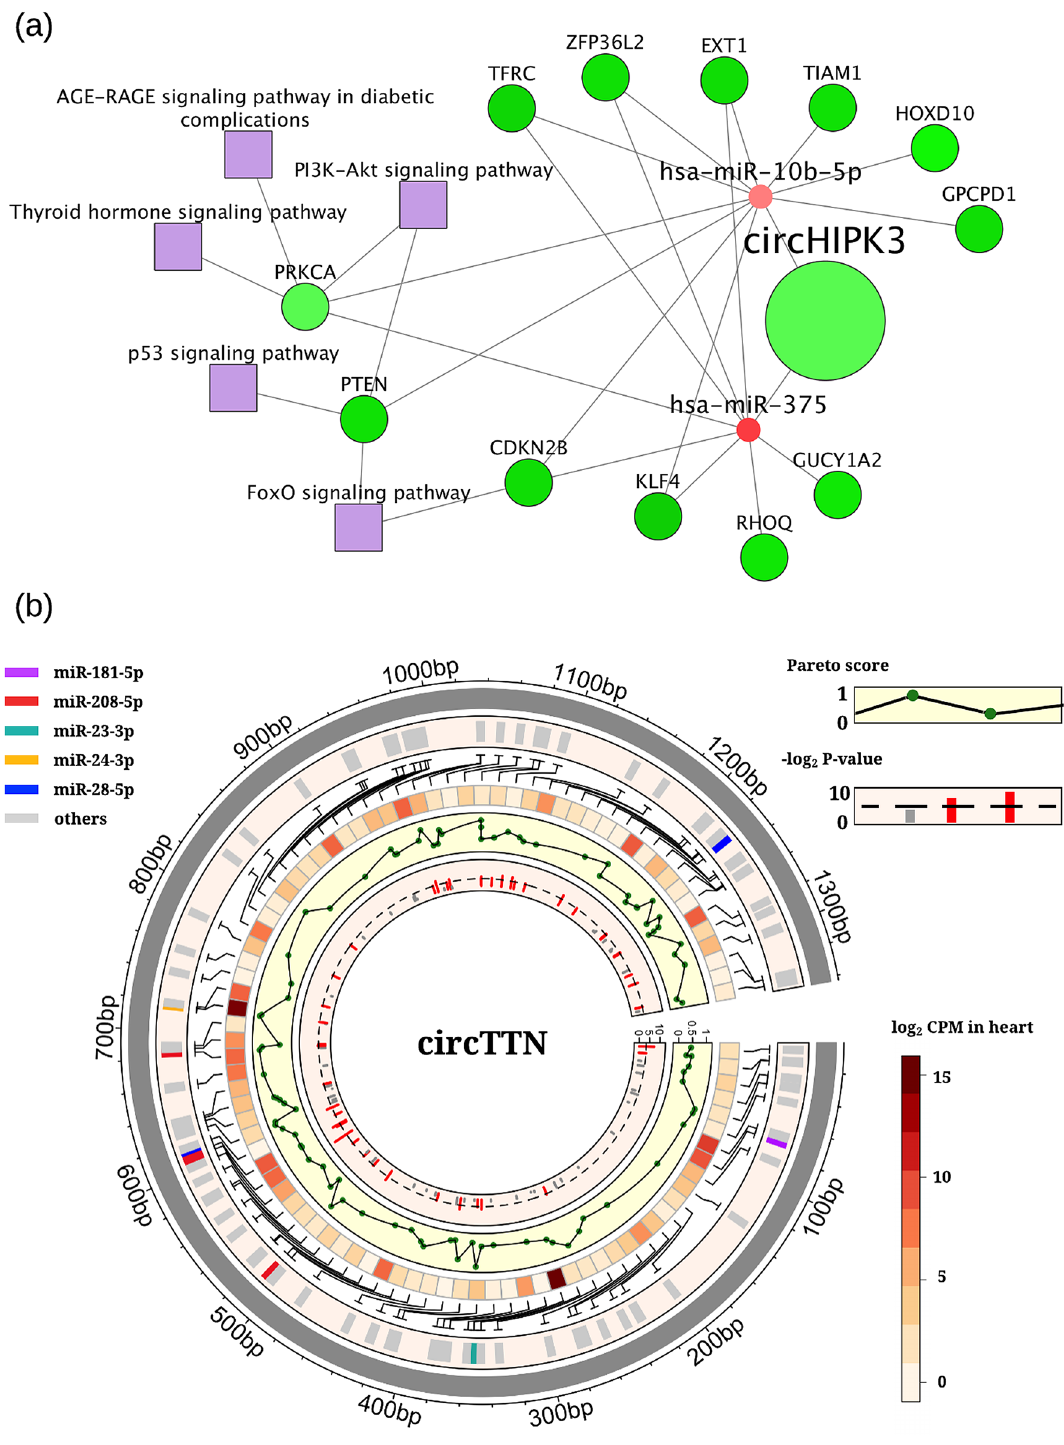
Figure 5. Cerina links circRNAs with potential functions in cancer and cardiovascular disease. ( a ) Network view of predicted circRNA-miRNA-gene-function associations for circHIPK3 in prostate cancer. For circRNA, miRNA, and genes, their colors represent their fold changes (red: up-regulated in prostate cancer; green: down-regulated in prostate cancer). ( b ) Circos plot showing predicted miRNAs of circTTN with Pareto score, expression in heart tissues (log 2 CPM), and enrichment in immunology functions (-log 2 p-value). Cytoscape v3.5.1 was used to create the circRNA-miRNA-gene-function network figure (https ://cytos cape.org/). R package circlize v0.4.8 (https ://cran.r-proje ct.org/web/packa ges/circl ize/index .html) was used to make circos